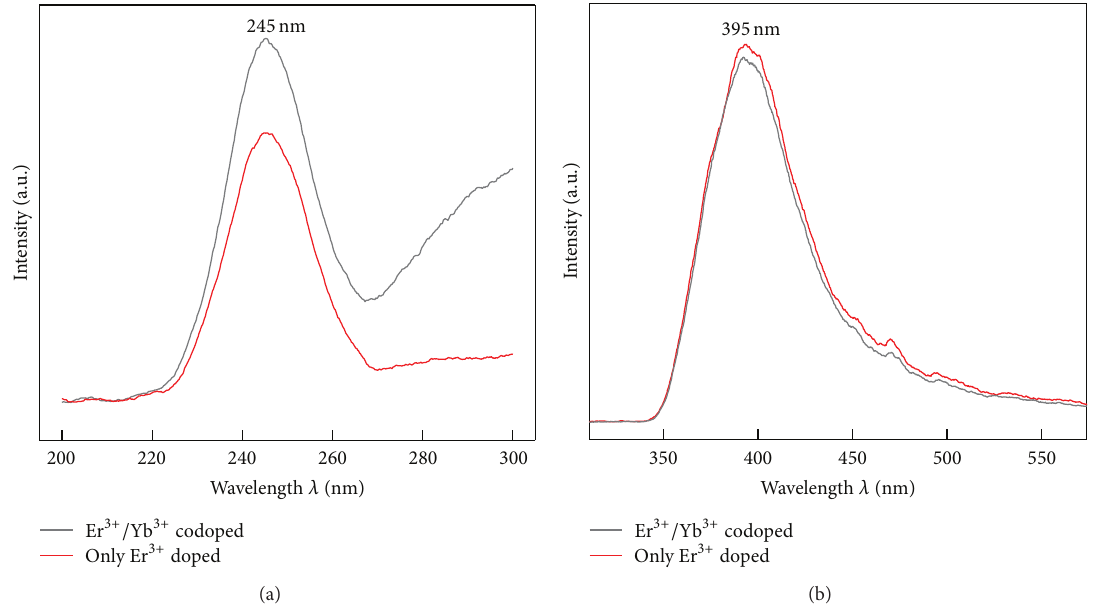
Figure 6: (a) Excitation and (b) emission spectra of the nanocrystal exposed to common xenon